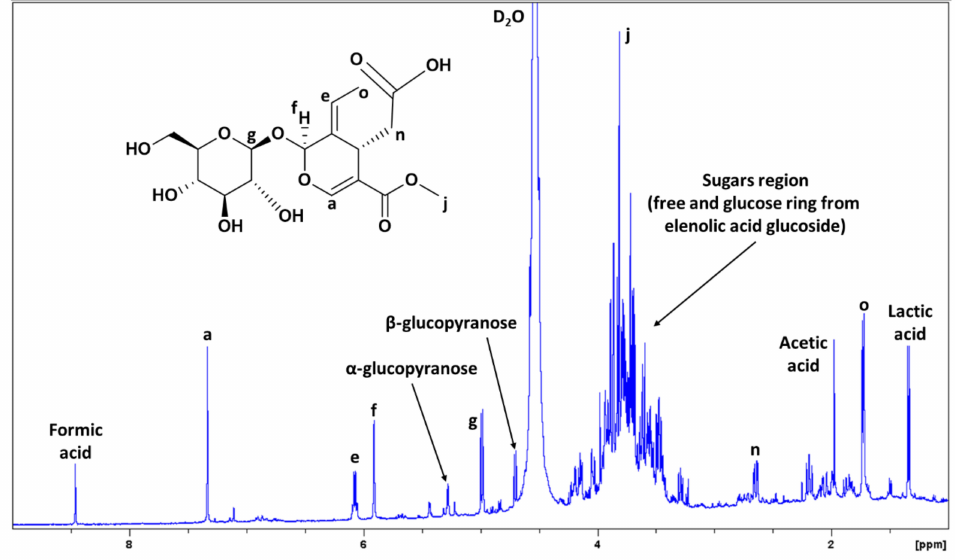
Figure 6. 1 H-NMR spectrum (500 MHz, D 2 O) from S1 aqueous phase after ethyl acetate extraction of table olive processing wastewater